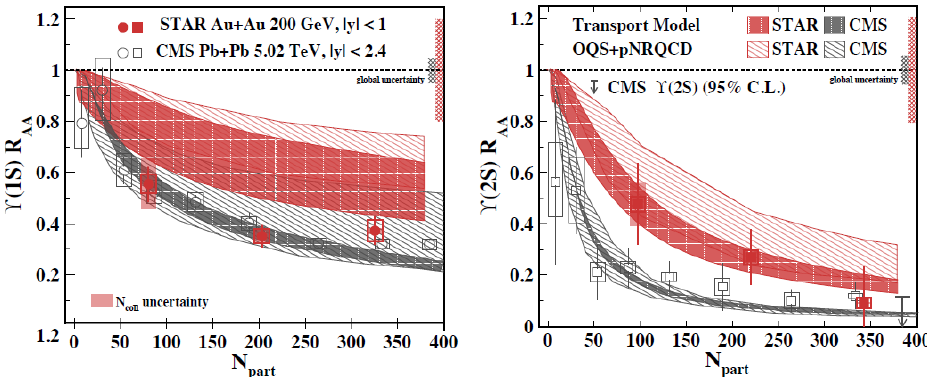
Figure 6: Nuclear modification factor R AA vs. N part for Υ (1 S ) (left) and Υ (2 S ) right measured by STAR and CMS